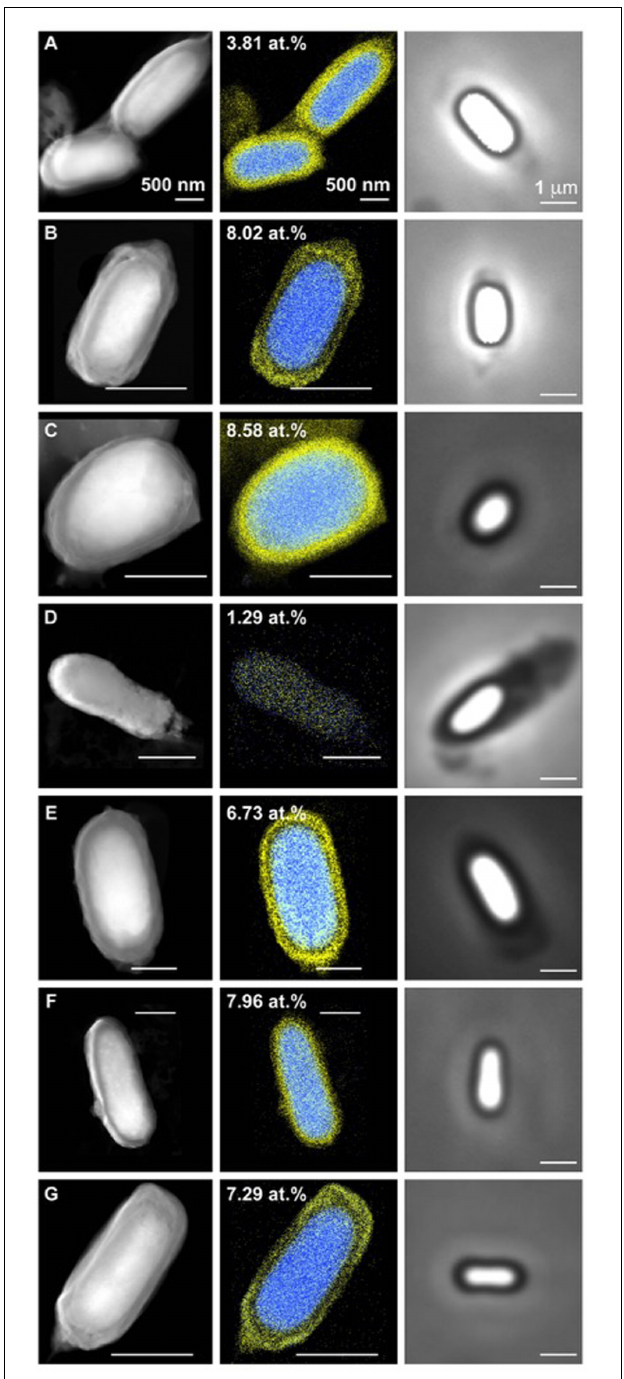
FIGURE 2 | Scanning Transmission Electron Microscopy coupled to energy dispersive spectroscopy (STEM-EDS) and bright field images of clostridial spores. (A) C. acetobutylicum DSM 792 (spore width 0.9 mm), (B) C. acetobutylicum DSM 1731 (spore width 0.5 mm), (C) C. collagenovorans DSM 3089 (spore width 0.8 mm), (D) C. beijerinckii DSM 791 (spore width 0.5 mm), (E) C. beijerinckii NCIMB 8052 (spore width 1 mm), (F) D. reducens MI-I (spore width 0.75 mm), (G) B. subtilis PY79 (spore width 0.5 mm). Calcium is false colored in blue and chlorine in yellow in EDS images. Number in EDS images represents atomic percentage of calcium.